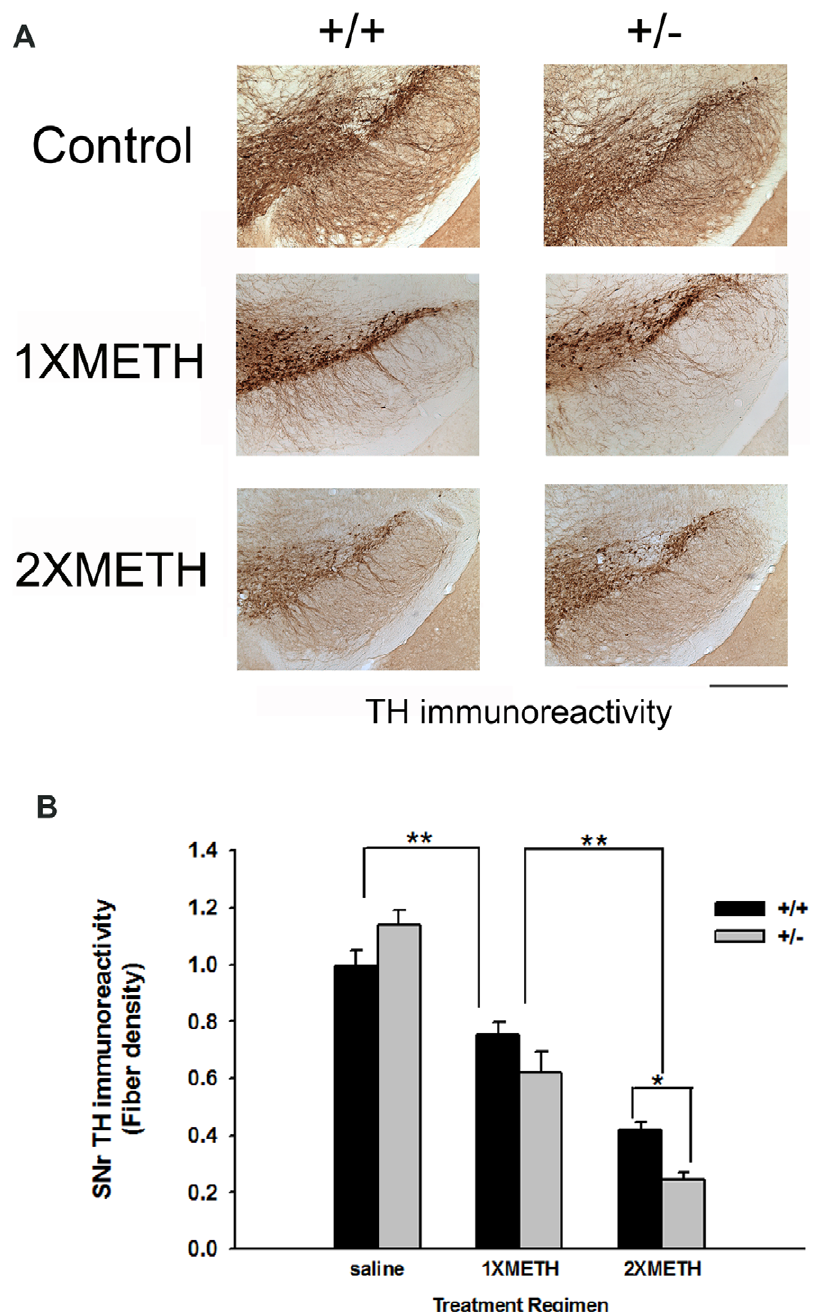
Figure 5. Nurr1 + / 2 mice exhibit decreased TH-immunoreactivity in SNpr following methamphetamine exposure. (A) TH immunostaining indicates that METH administration augments the reduction in THir in the SNpr of Nurr1 + / 2 , compared to + / + mice following repeated METH binge treatment. Calibration bar=500 um. (B) THir fiber density analysis indicated METH treatment (1xMETH) reduced THir fiber density in SNpr in + / + and + / 2 mice (p , 0.001, Two-way ANOVA) and repeated METH binge treatment (2XMETH) further reduced THir fiber density in SNpr (p , 0.001, Two-way ANOVA). A trend of greater reduction in TH immunoreactivity was found in the Nurr1 + / 2 mice following 1XMETH (p=0.058, Two-way ANOVA, post hoc Newman-Keuls test) and a significant decrease in THir in SNpr was found in Nurr1 + / 2 mice following repeated METH treatment (2XMETH). (p , 0.05, Two-way ANOVA, post hoc Newman-Keuls test).